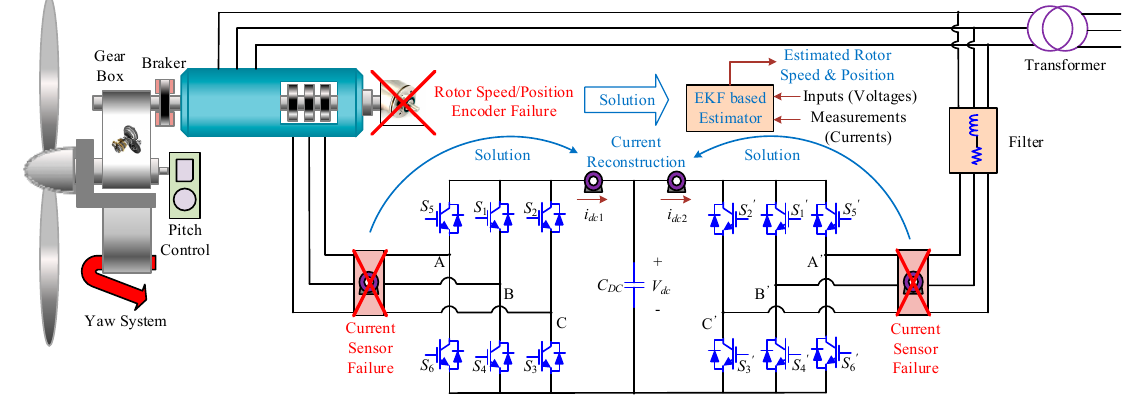
Figure 1. The severe sensor fault scenario in a doubly-fed induction generator-based wind turbine (DFIG-WT).